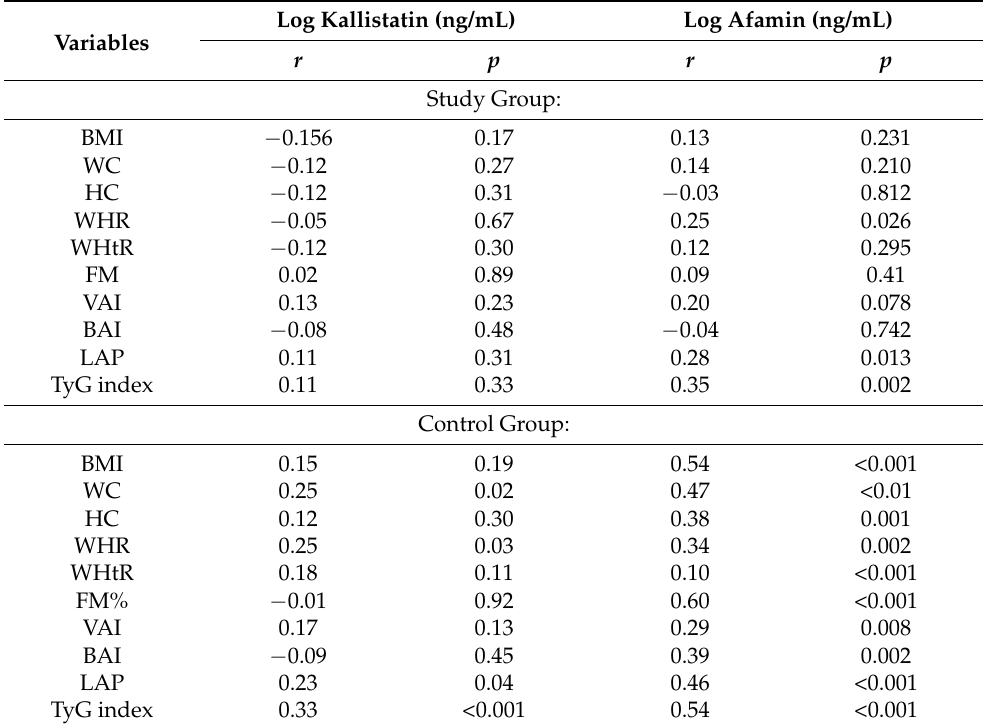
Table 2. Correlation between kallistatin and afamin serum level and anthropometric